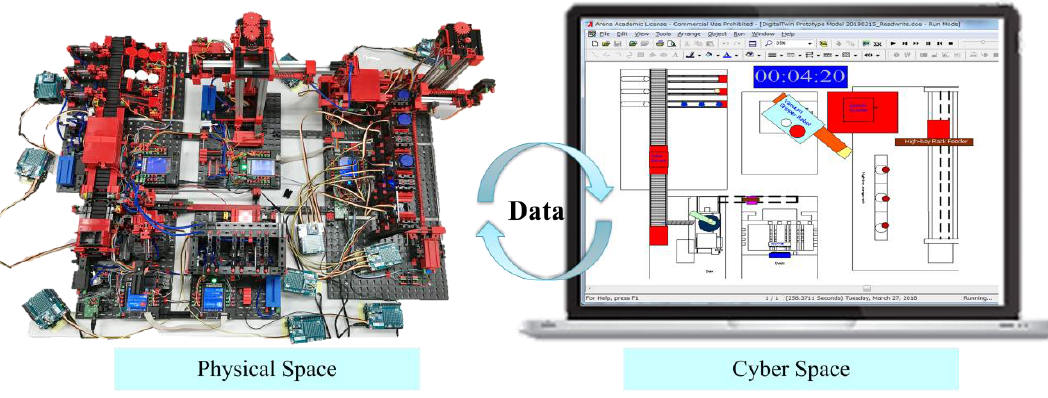
Figure 9. A DT schematic diagram of the factory.